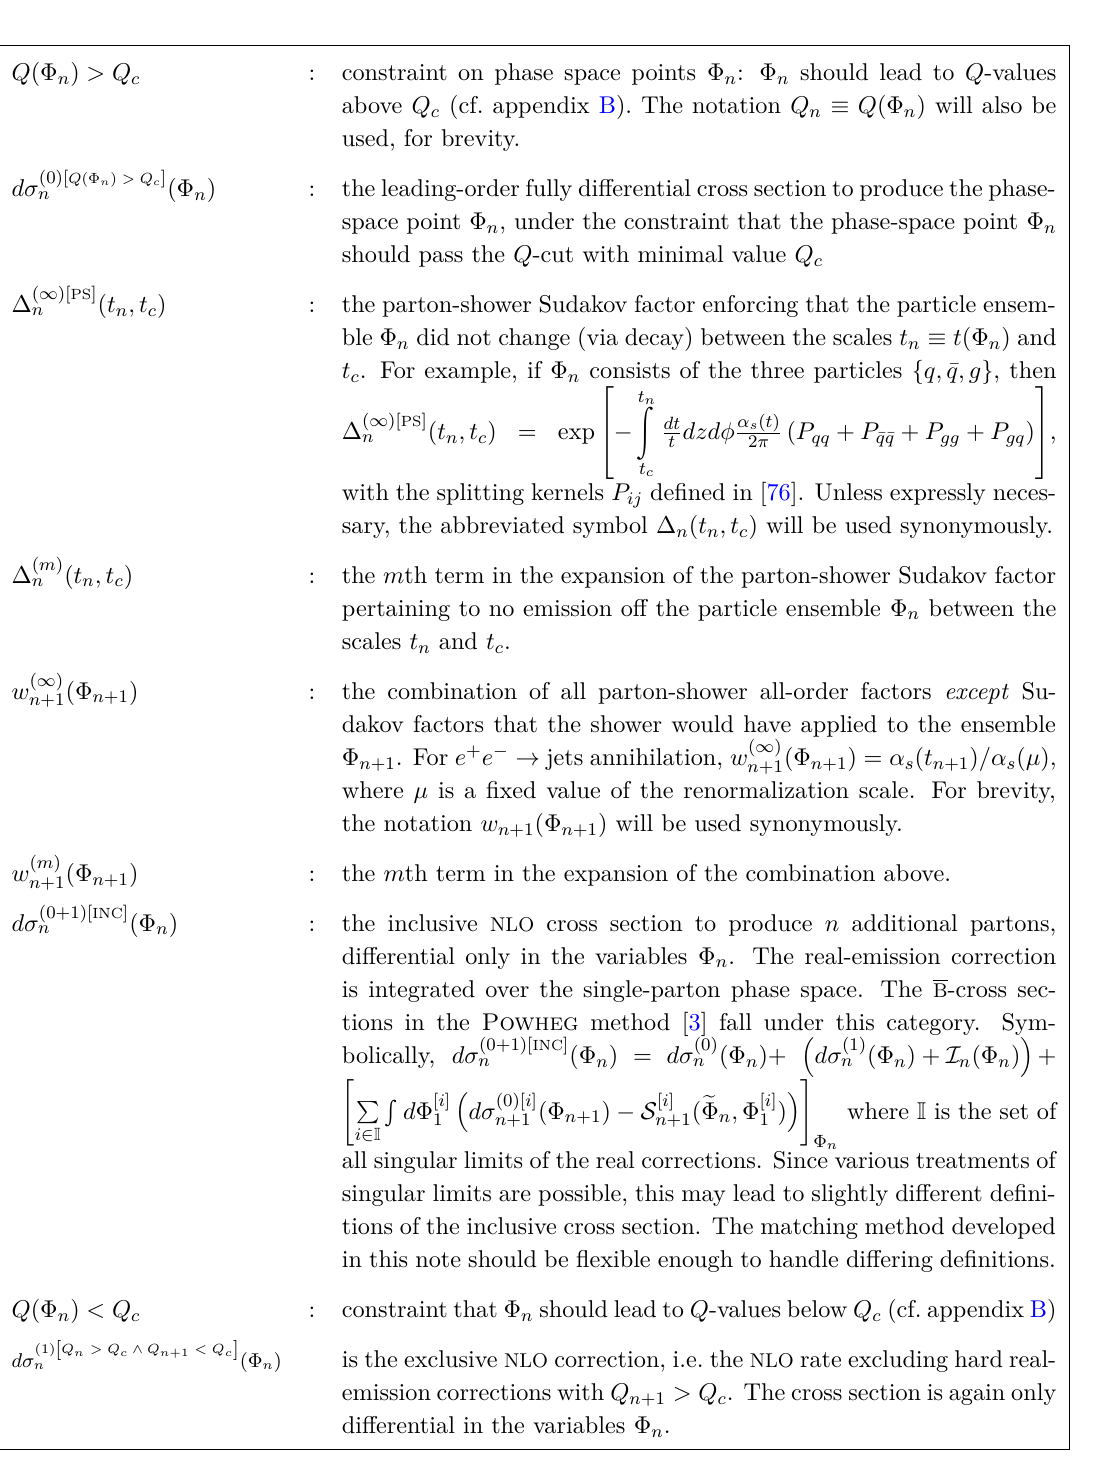
Table 2 . Some symbols that will feature heavily in this note. More details on (inclusive and exclusive) fixed-order cross sections can be found in appendix